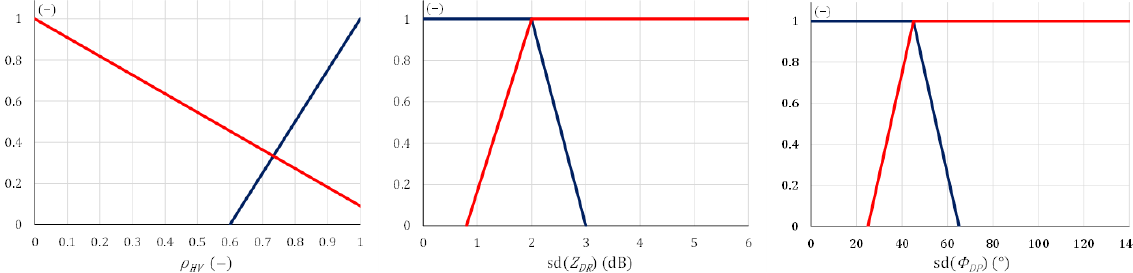
Figure 4. Membership functions for selected polarimetric parameters from the left – ρ HV , SD (Z DR ) , and SD ((cid:56) DP ) – determined for meteorological (in navy) and non-meteorological echoes (in red). Table 3. Monthly precipitation accumulations determined for the lowest elevation (0.5 ◦ ) at locations of wind turbines, other disturbing objects, and undisturbed locations. Data from Ram˙za radar, September 2018. Kind of object Azimuth Distance from the R raw (mm) – R DP . TURBINE (mm) – R bg (mm) – Effectiveness of ( ◦ ) radar site raw data after DP.TURBINE background the algorithm (km) Wind turbines 16 54 1371 302 0.83